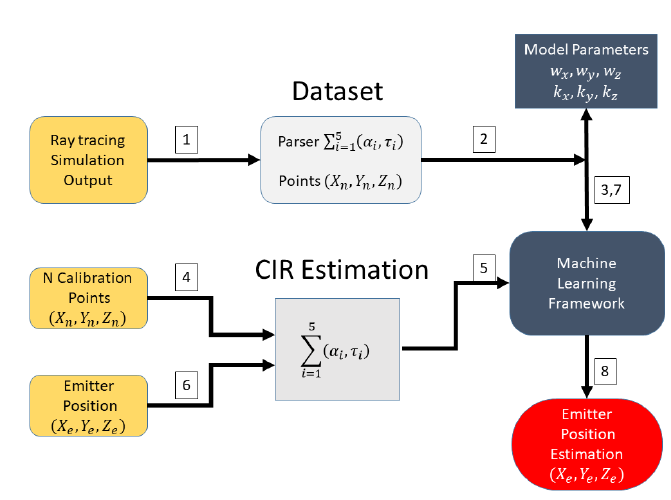
Figure 12. Machine learning ray-tracing dataset refinement.